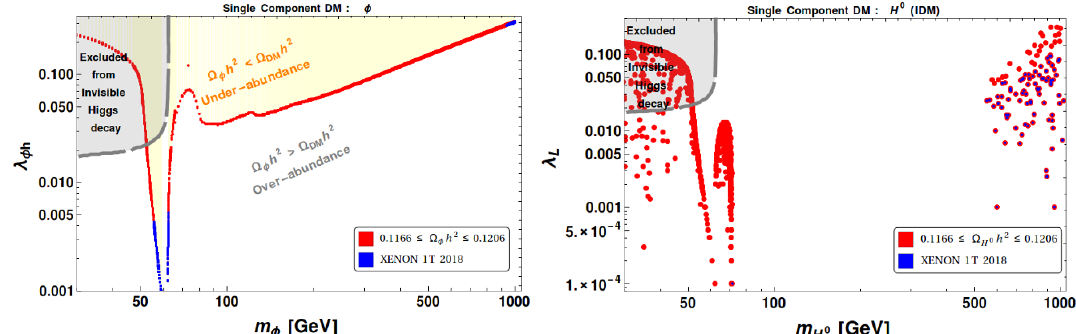
Figure 5 . Relic density (red dots) and direct search/XENON1T (blue dots) allowed parameter space of the single component DM; scalar singlet ( (cid:30) ) on left (in m (cid:30) (cid:0) (cid:21) (cid:30)h plane) and IDM ( H 0 ) on right (in m (cid:0) (cid:21) L plane). For the right hand side plot, we have used: 0 (cid:20) m H 0 1 (cid:20) m (cid:0) m (cid:20) 400 GeV, and (cid:21) (cid:8) = 0 : 001. H 0 H (cid:6)